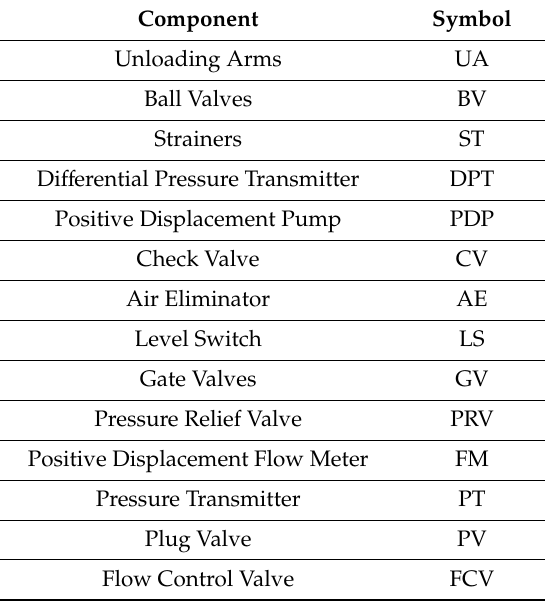
Table 2. Unloading system components